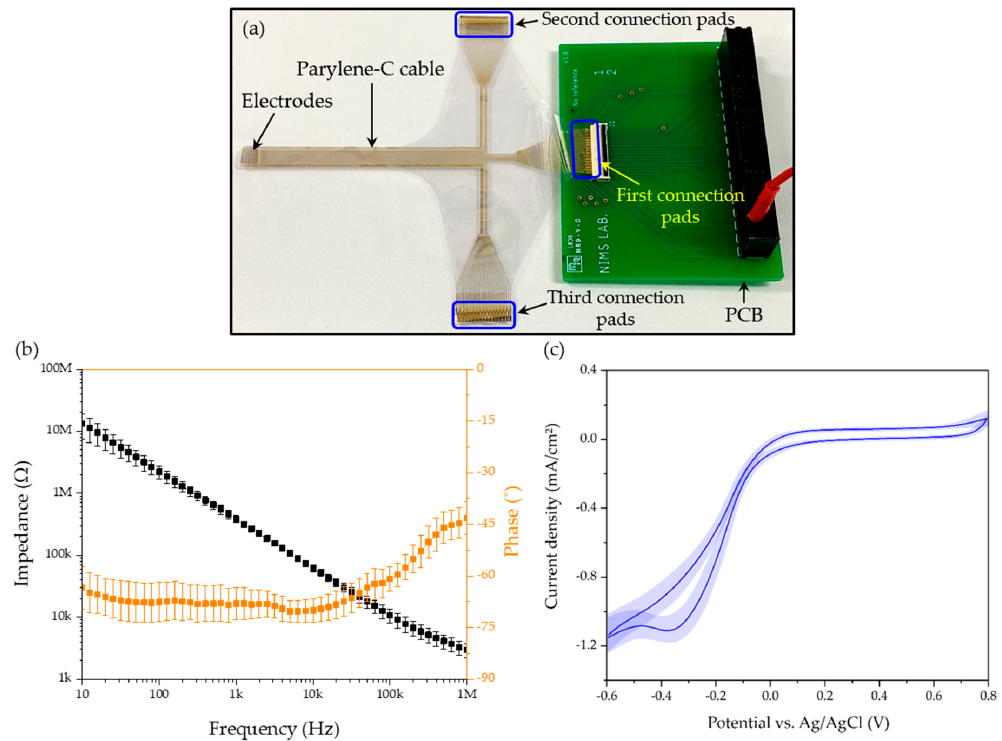
Figure 7. ( a ) Completed electrode array integrated with parylene-C cable and printed circuit board (PCB), for electrochemical characterization. ( b ) Measured impedance of fabricated microelectrodes. Means and standard deviations for magnitude and phase are shown. ( c ) Cyclic voltammogram curves of the Pt-coated electrodes measured at a scan rate of 50 mV·s − 1 .